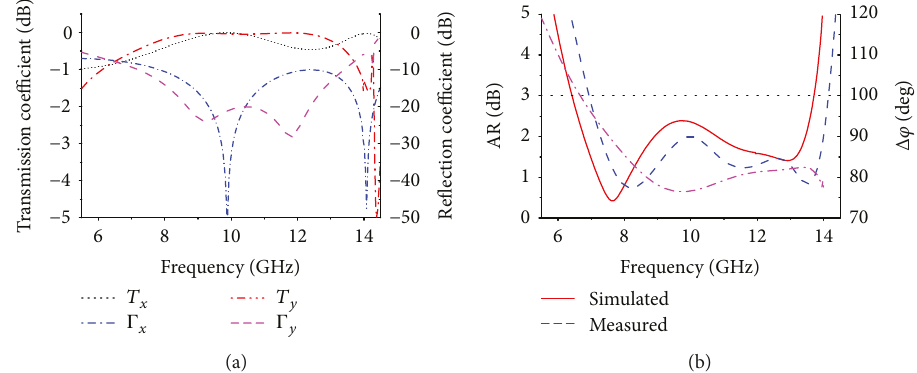
Figure 7: Simulated and measured results for normal incidence. (a) Transmission and re fl ection coe ffi cients. (b) Phase di ff erence and AR of the transmitted wave.